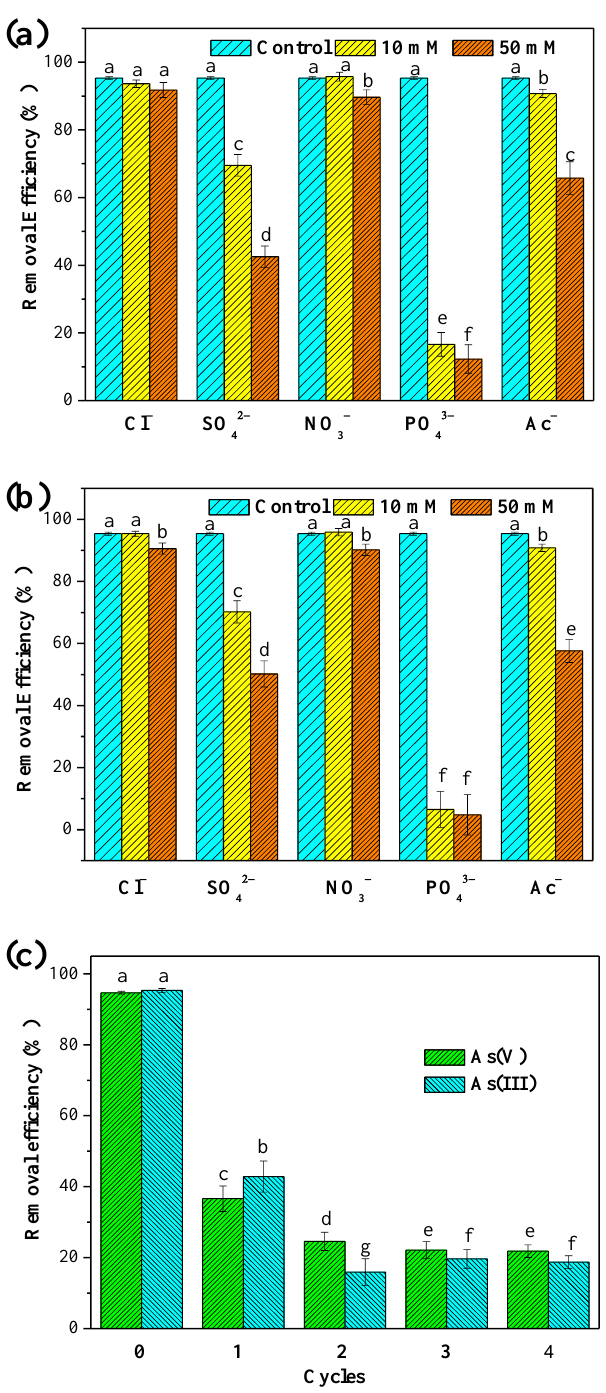
Figure 5. Effect of competitive anions on the removal of As(V) ( a ) and As(III) ( b ) at pH 4.0. ( c ) Reusability of MnO 2 @La(OH) 3 nanocomposite on arsenic removal. Experimental conditions: the initial As concentration was 65 mg/L. The removal efficiencies of the control group were the removal efficiencies of As removal in the absence of the co-existing at pH 4.0. Different letters indicate significant differences in the ANOVA (α < 0.05).